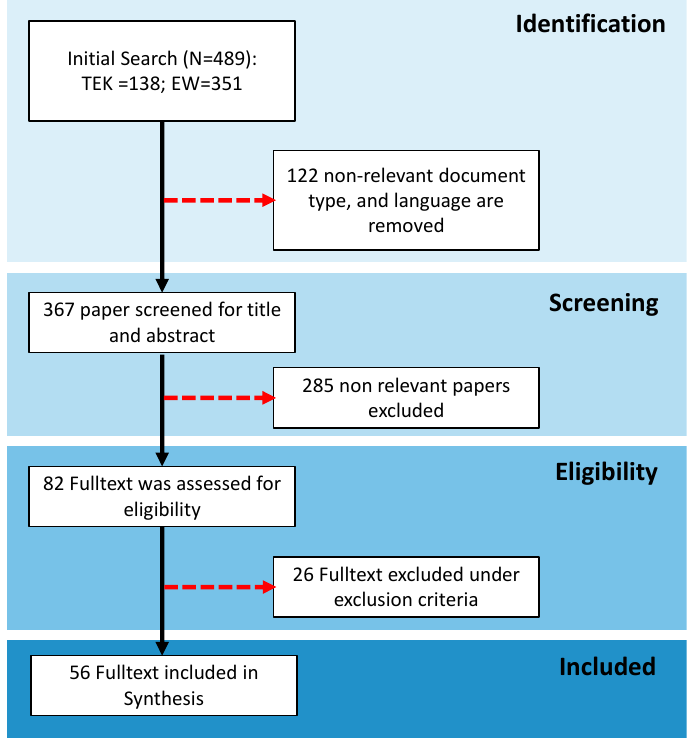
Figure 1. Data collecting and selection process. Table 1. The inclusion and exclusion criteria.